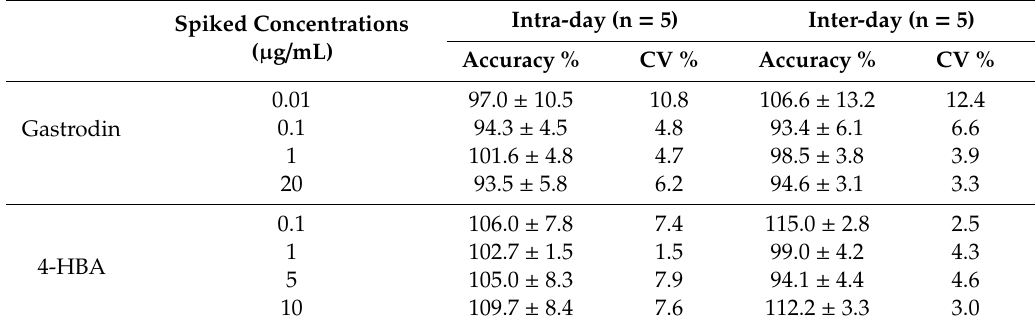
Table 1. Intra-day and inter-day analytical validations of gastrodin and 4-hydroxybenzyl alcohol (4-HBA) in rat plasma.